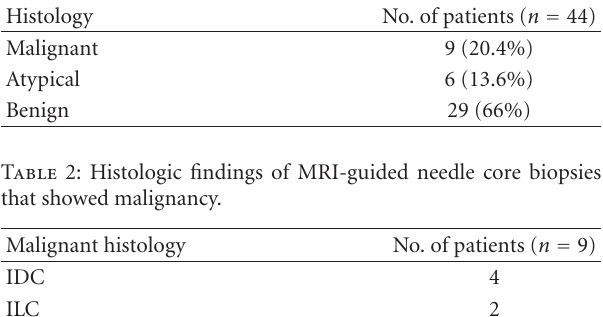
Table 1: Histologic findings of MRI-guided needle core biopsies. Histology